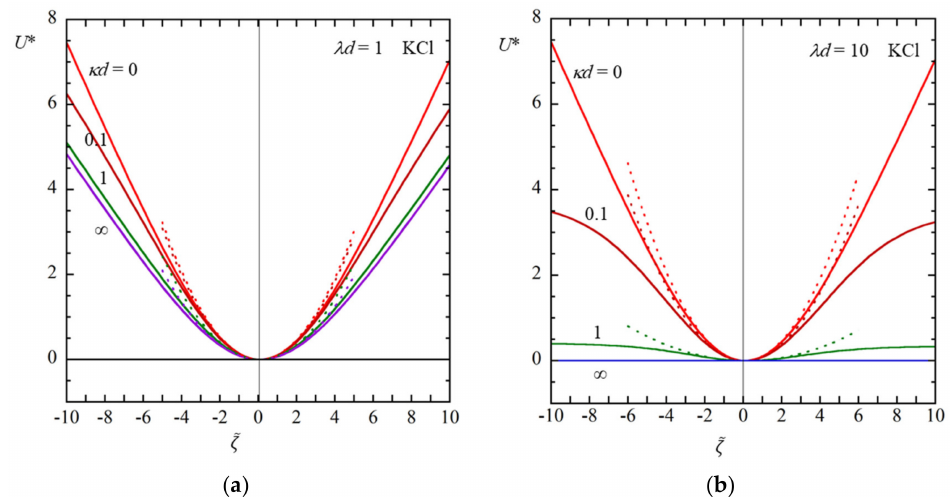
Figure 3. Scaled diffusiophoretic mobility U * of a large soft particle as a function of the scaled zeta potential (cid:101) ζ for several values of κ d at λ d = 1 ( a ) and λ d = 10 ( b ) in an aqueous KCl solution ( β = − 0.02). Solid lines are results obtained with Equation (61). Results obtained with a low potential approximation with Equation (66) are also given as dotted lines.